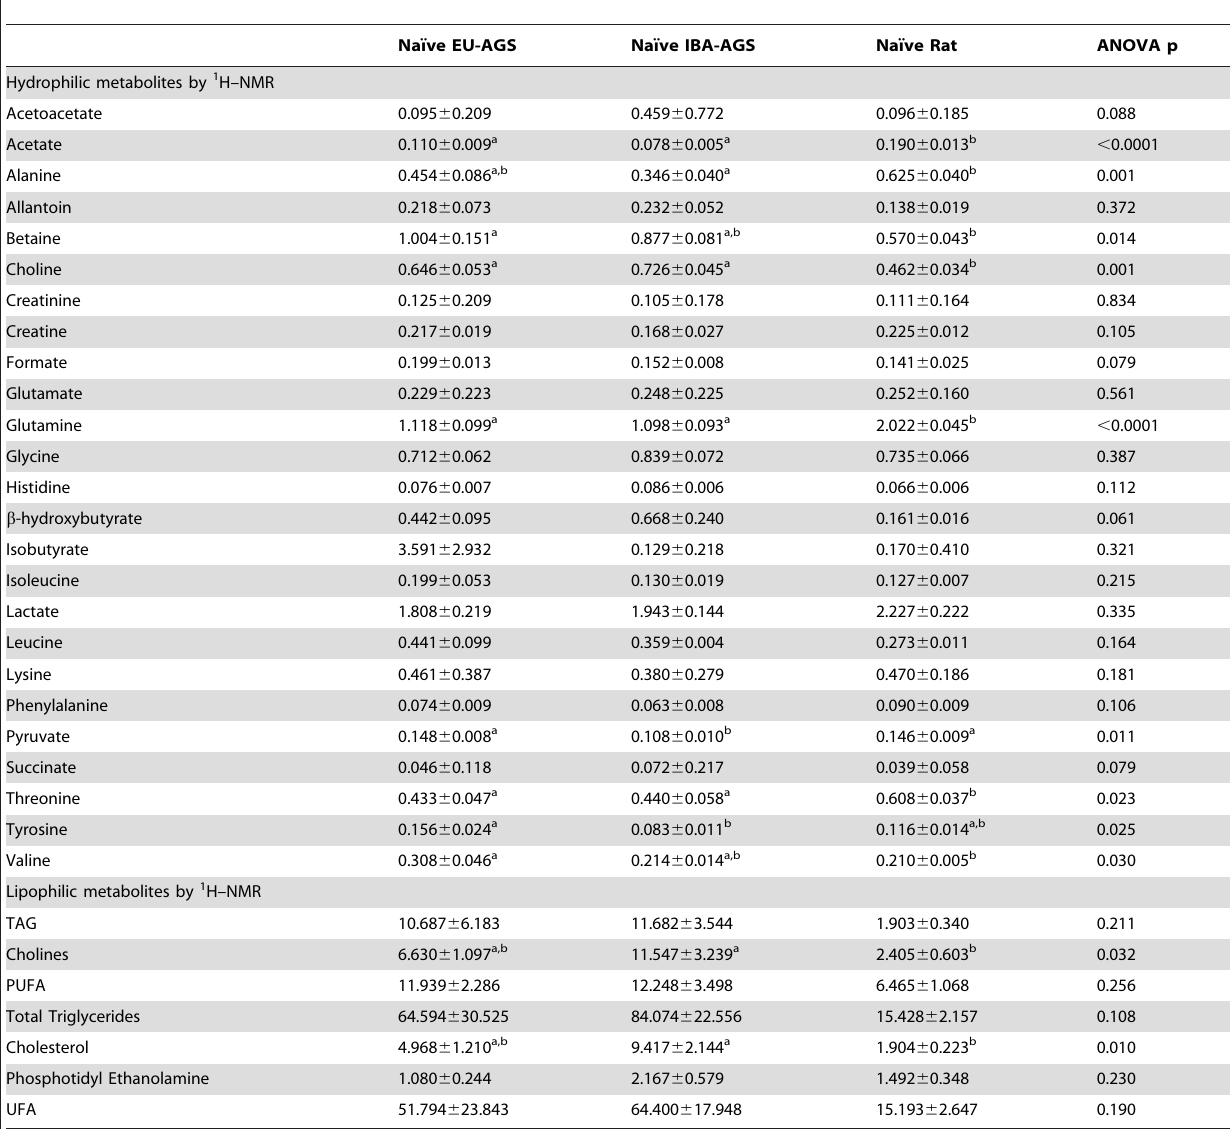
Table 1. Average concentrations (mM plasma) and SEM of metabolites in naı¨ve animals for summer euthermic (EU) arctic ground squirrels, winter interbout arousal (IBA) arctic ground squirrels, and